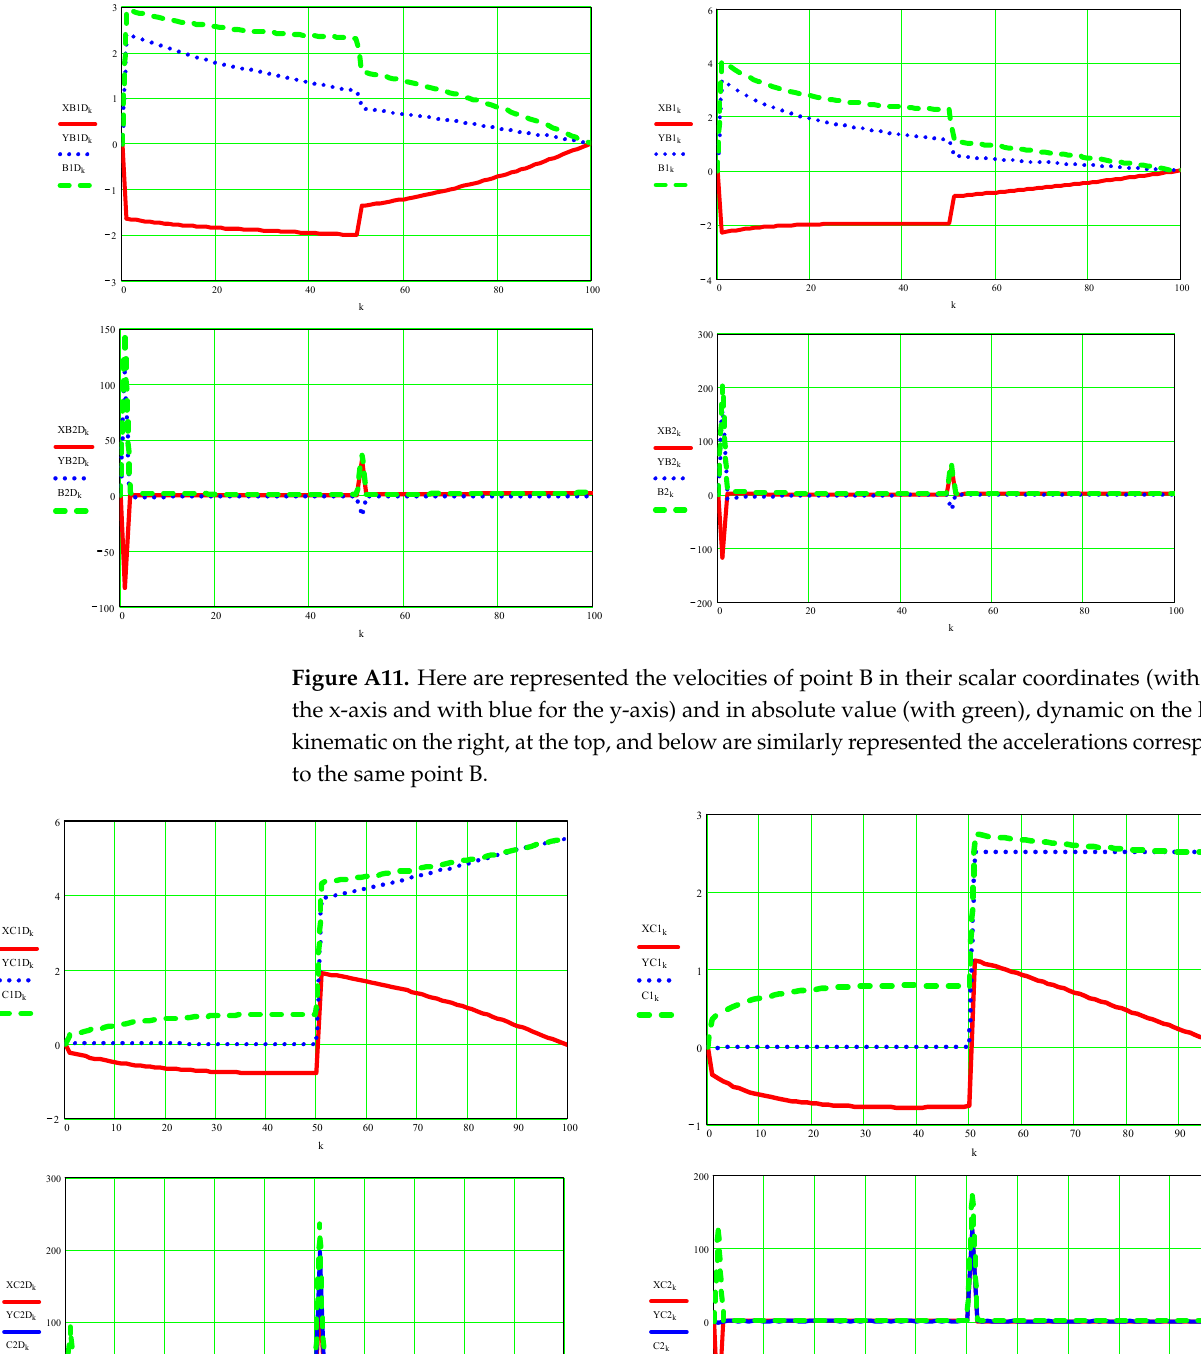
Figure A12. Here are represented the velocities of point C in their scalar coordinates (with red for the x-axis and with blue for the y-axis) and in absolute value (with green), dynamic on the left and kinematic on the right, at the top, and below are similarly represented the accelerations corresponding to the same point C.